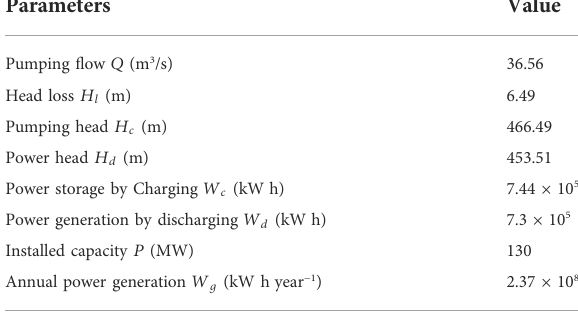
TABLE 2 Power Conversion of the charging and discharging process.